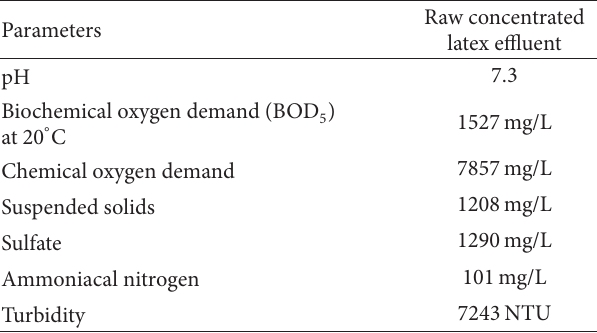
T 2: Values of selected parameters of raw concentrated latex